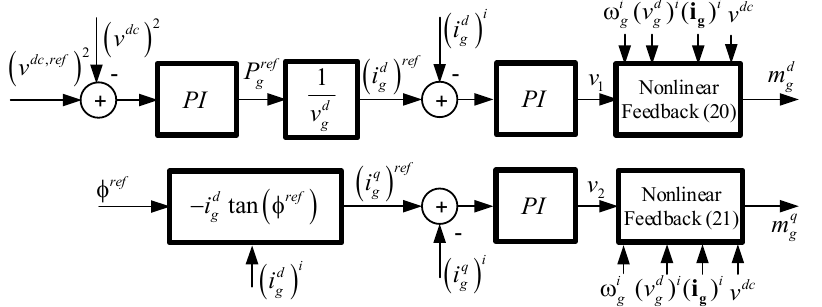
Figure 3. Power converter rectifier with a dynamic decoupler control.